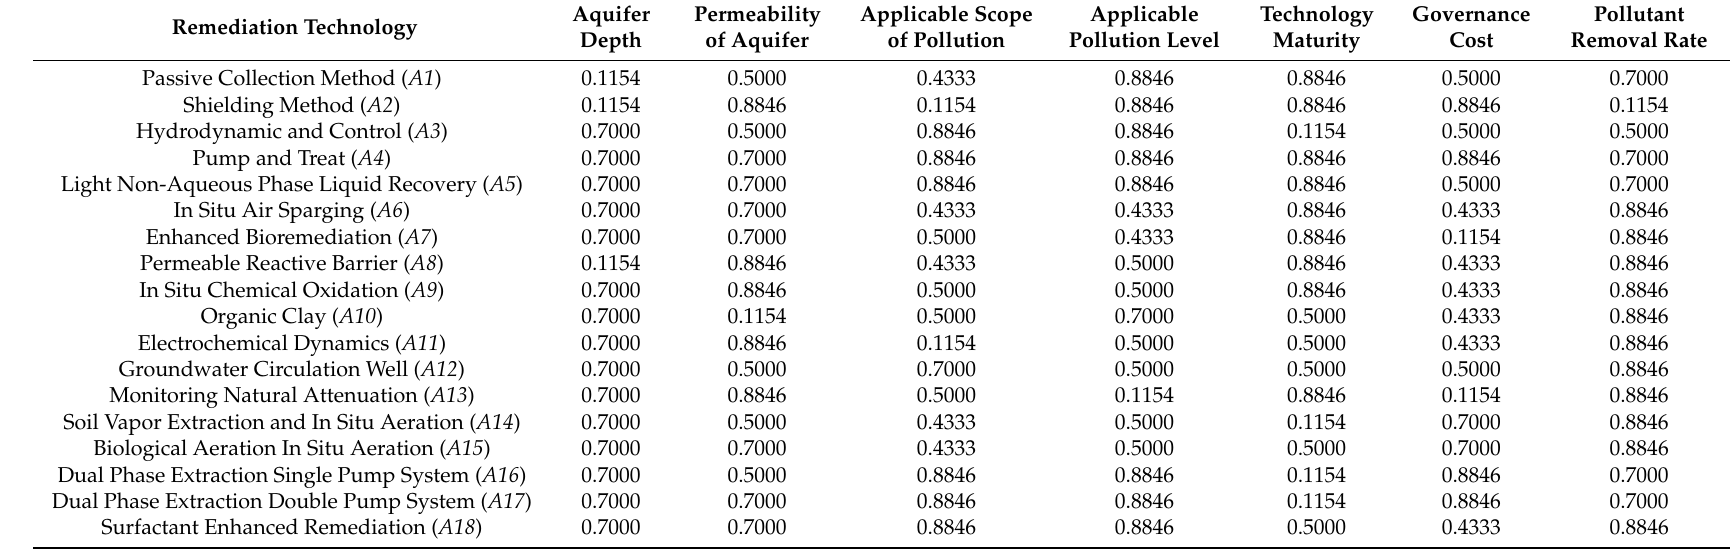
Table 6. The description of indicators in mathematical